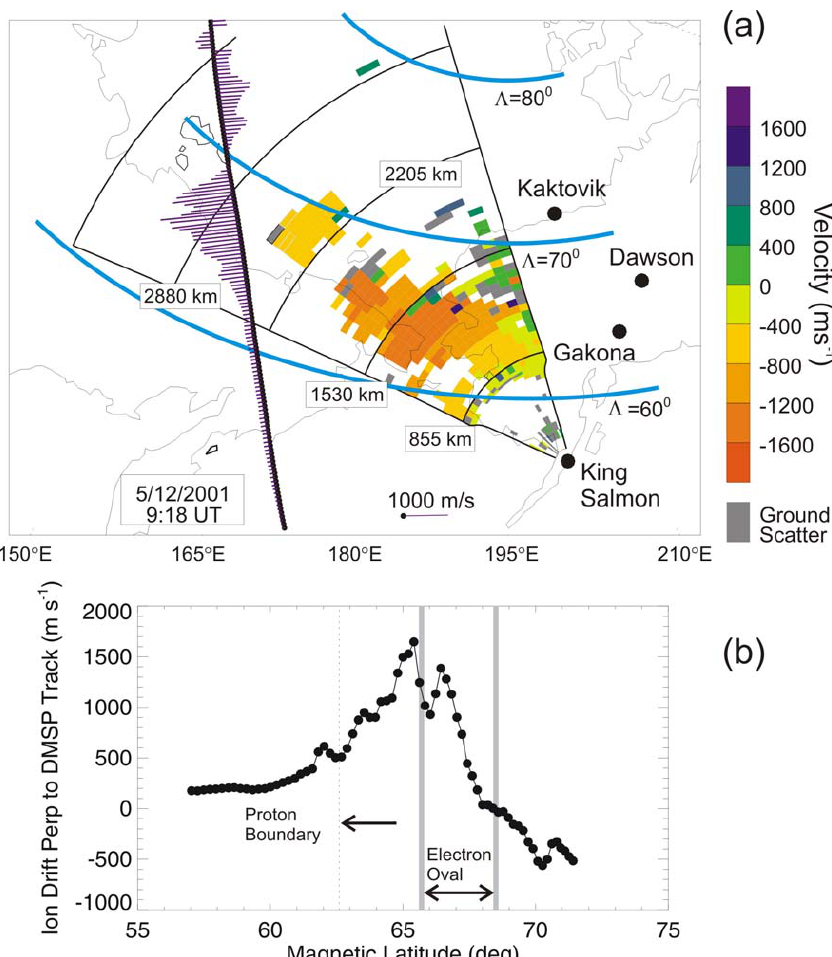
Fig. 9. (a) King Salmon velocity map for 5 December 2001, 09:18 UT with overlaid DMSP cross-track ion drifts for a DMSP F 15 pass near the time of radar measurements. (b) A line plot of the ion drift data shown in panel (a), latitudes of the auroral electron precipitations and the equatorward boundary of the proton aurora. For the boundary identification, DMSP particle data were considered. The peak in the ion drift roughly coincides with the equatorward edge of the electron precipitation and relatively fast flow exists equatorward of this edge for several degrees of magnetic latitude.